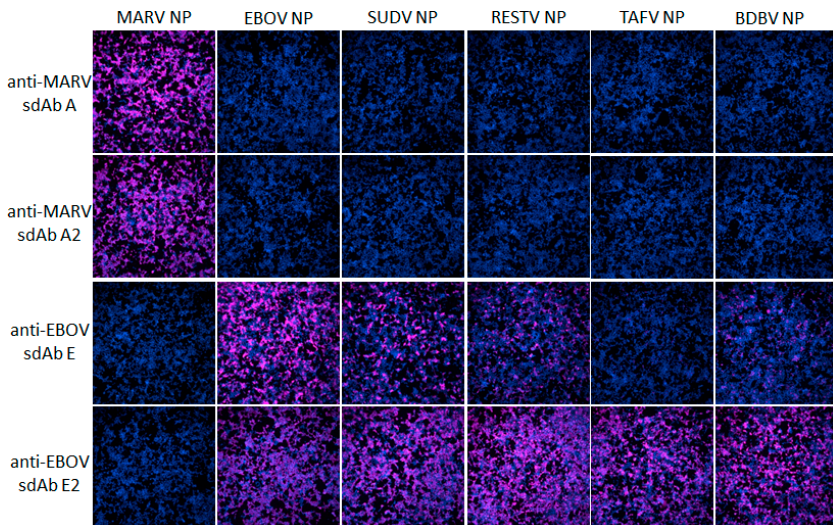
Figure 3. HEK293T cells were transiently transfected with various NP expression plasmids indicated at the top of the panels. At 24 h post-transfection, the cells were probed with 10 nM of the various sdAb–APEX2 fusion proteins indicated to the left of the panels, developed for 30 min with Amplex® Ultra Red, and visualized with fluorescence microscopy at 10× magnification.